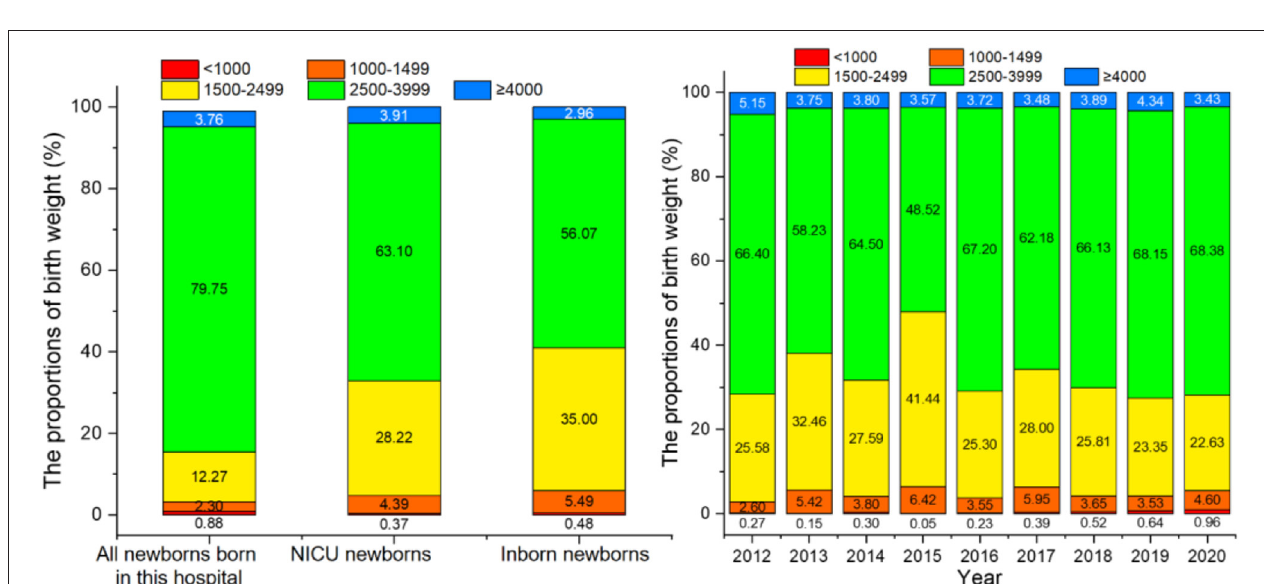
FIGURE 4 | The birth weight distribution of newborns (left) and the birth weight of newborns from 2012 to 2020 (right).